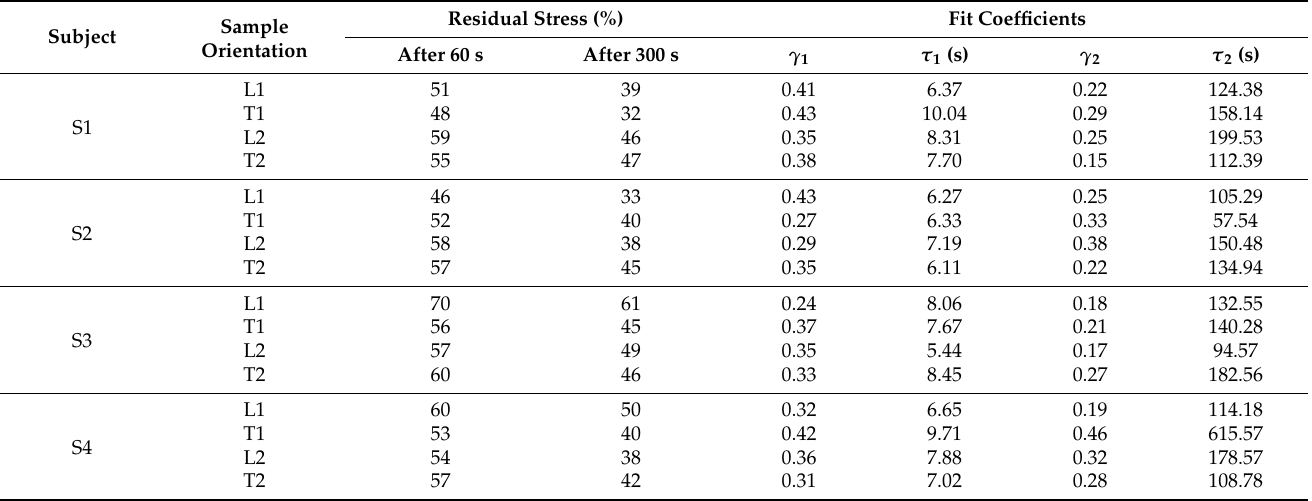
Figure 4. From ( a – d ) median stress relaxation curves after 300 s of relaxation time for the fourth subjects along longitudinal (L) and transversal (T) directions of layer 1 or 2. Color bands refer to the first and third percentiles. Table 2. Normalized residual stress (% of the peak, which is equal to 100%) after stress relaxation. Median is reported after 60 s and at the end of the relaxation time (300 s). Fitted parameters γ and τ refer to the two-term Prony series reported in Equation (7).